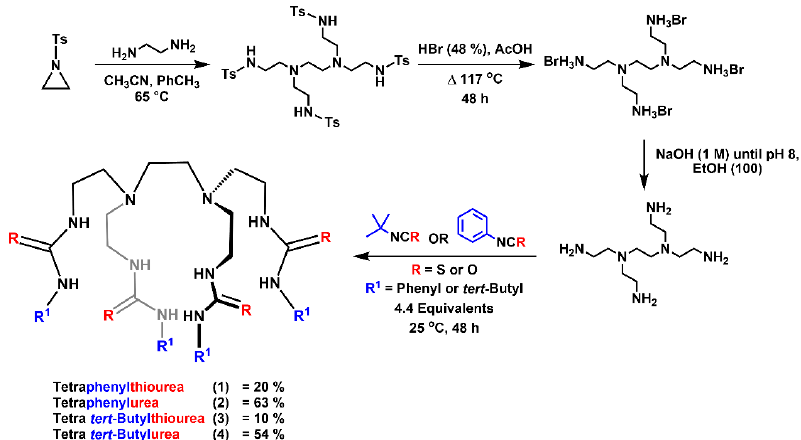
Figure 2. The synthetic scheme of receptors 1 – 4 , where (R) denotes either a urea group (O) or a thiourea group (S) and ′ R 1 ′ represents the pendant phenyl or tert -Butyl functional group.